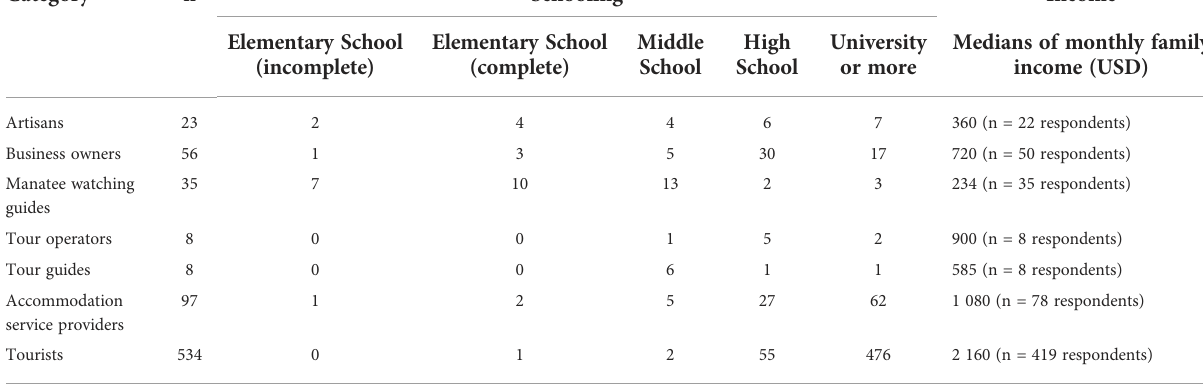
TABLE 2 Level of education and income of the interviewed categories.